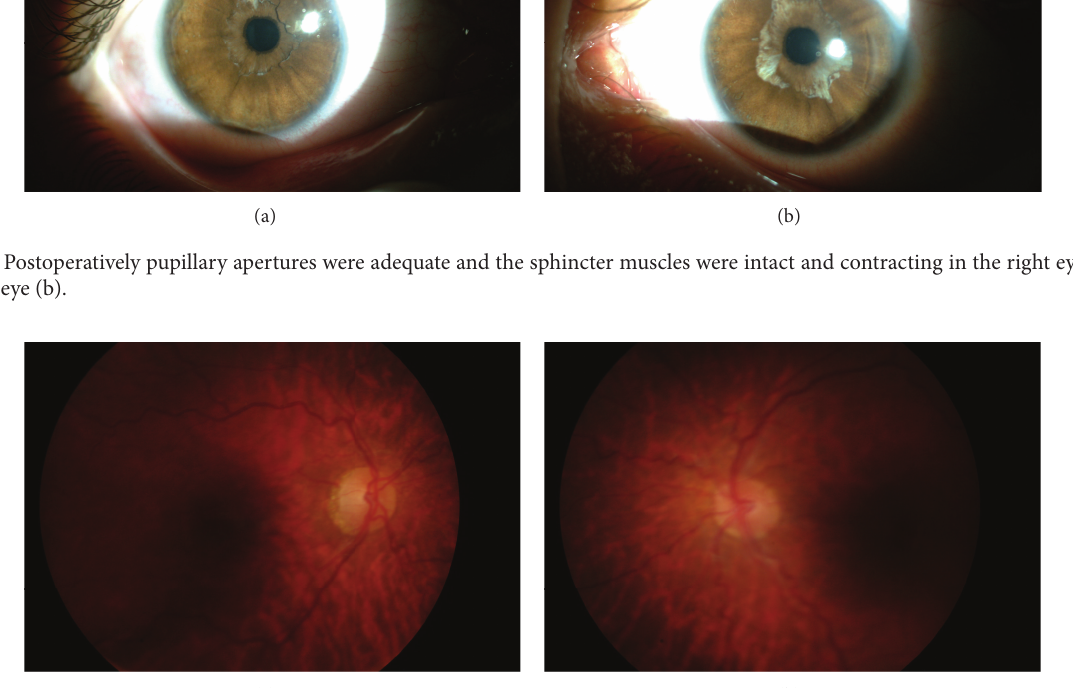
PPM are usually nonpathogenic physical sign of normal intrauterine development [1]. The lens is always clear